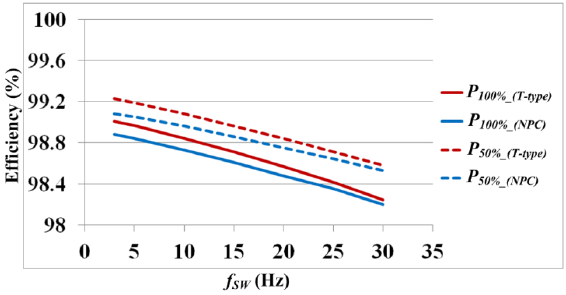
Figure 5. E ffi ciencies of T-type and NPC inverters with di ff erent switching Figure 5. Efficiencies of T-type and NPC inverters with different switching frequencies.